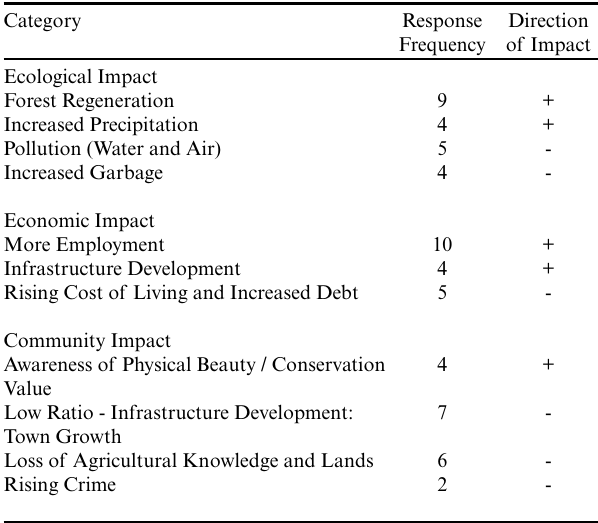
Table 5. Tourism trade-offs. These themes arose in response to the question, “Does nature tourism benefit people and the environment in the region?” Responses are grouped by category and frequency, where the frequency indicates the number of people who mentioned the theme. Direction of impact indicates whether the respondent considered the result to be positive or